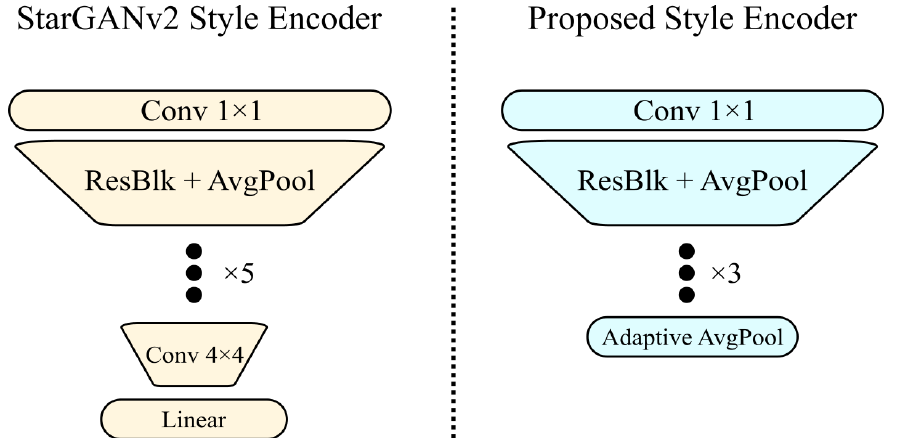
Figure 2. Proposed style encoder architecture. As opposed to StarGANv2, we removed shape information using a pooling function and removing the last two downsampling